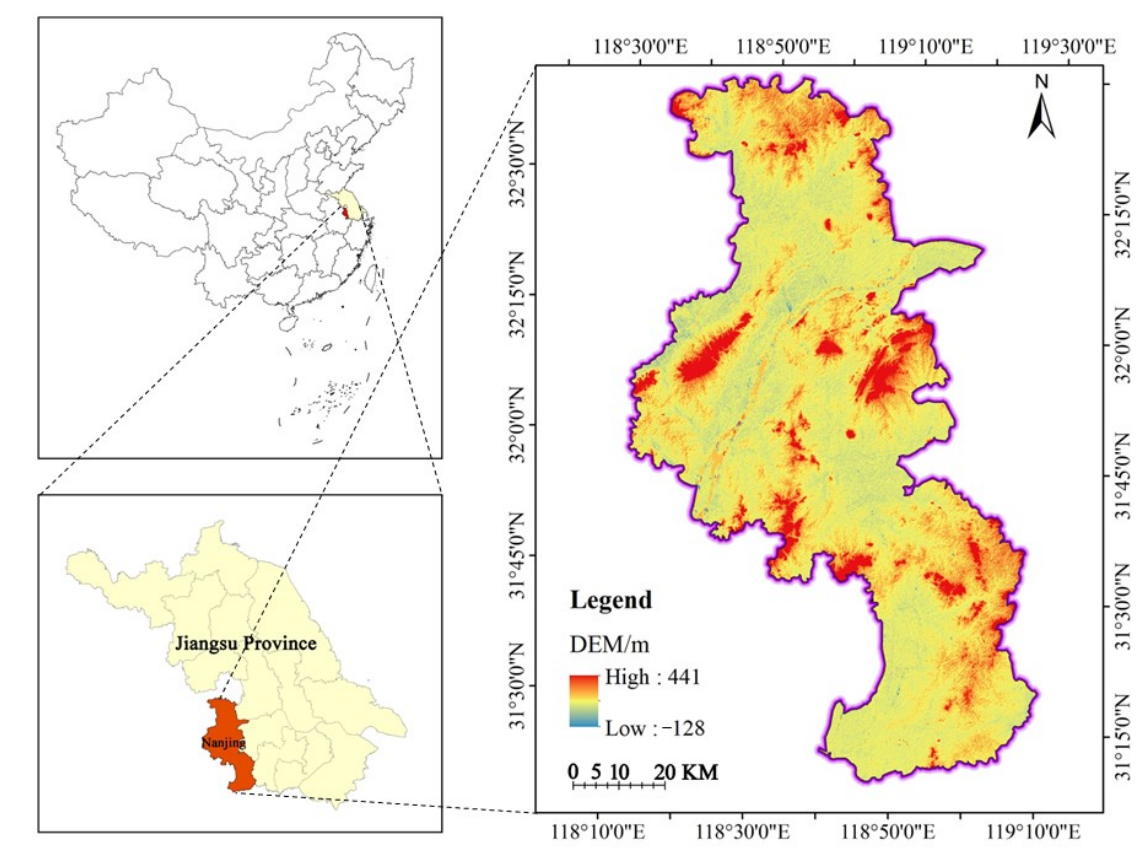
Figure 1. Location of the study area.